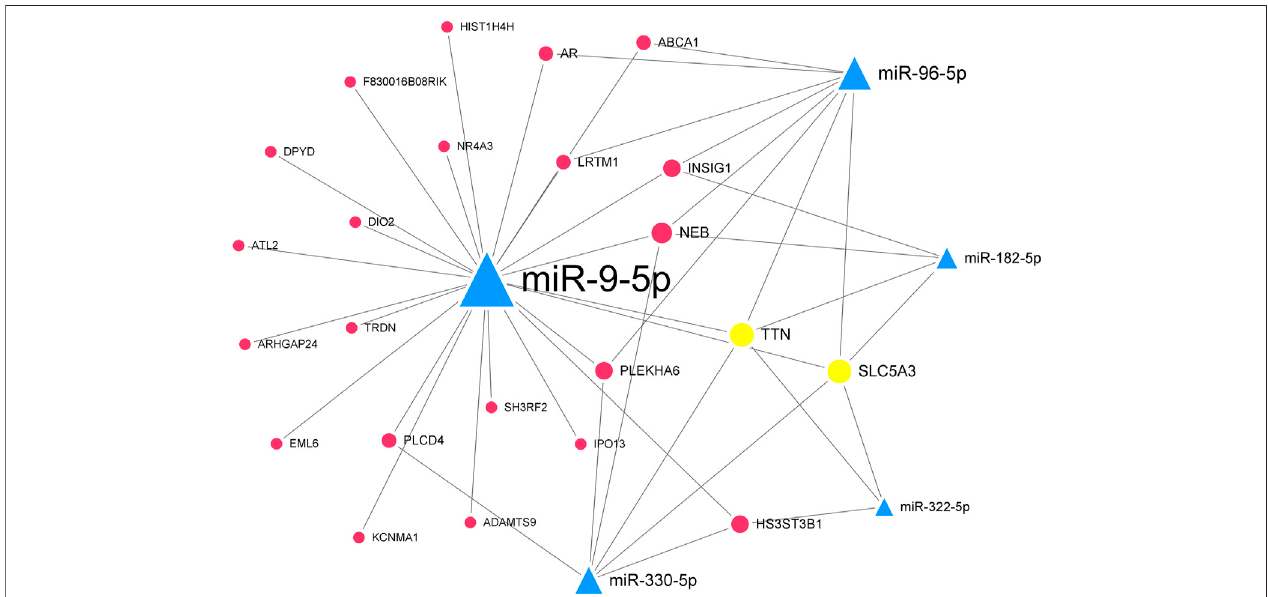
FIGURE 6 | The hub downregulated miRNA-upregulated mRNA interaction network in Md fi -OE vs. WT.The network displays the hub miRNA-mRNA interactions. Nodes representmiRNA and mRNA, and edgesrepresentinteractions.The downregulatedmiRNAsareshown ingreen, upregulated genesare shown inblue, and hub genes are shown in gold. The miRNAs are depicted by triangles and the genes as